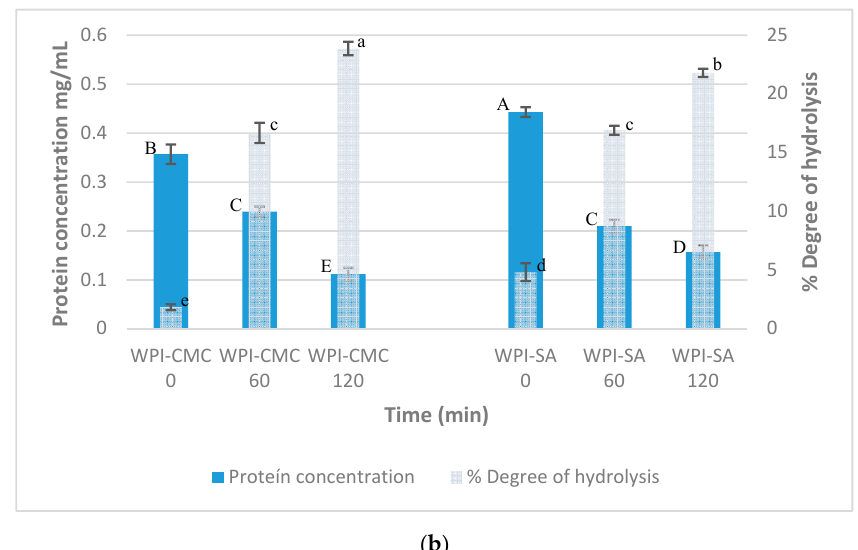
( b ) Means with different letters differ significantly ( p ˂ 0.05). Capital letters refer to protein concentration; small letters referes to % degree of hydrolysis. Figure 6. Protein concentration and degree of hydrolysis during gastric digestion at ( a ) 0 and 120 min and during intestinal digestion at ( b ) 0, 60, and 120 min for the WPI–CMC and WPI–SA systems.